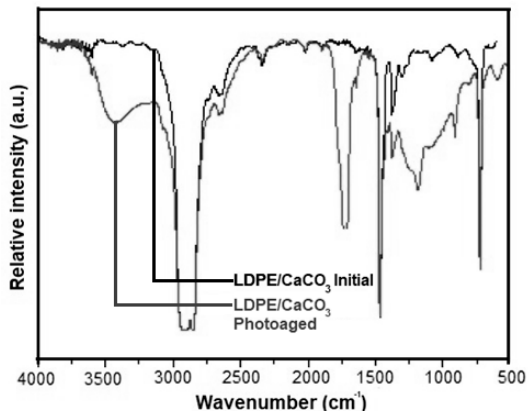
Figure 6. Infrared (IR) spectra of initial LDPE/CaCO 3 nanocomposites and LDPE/CaCO 3 after photoaging for 35 days.